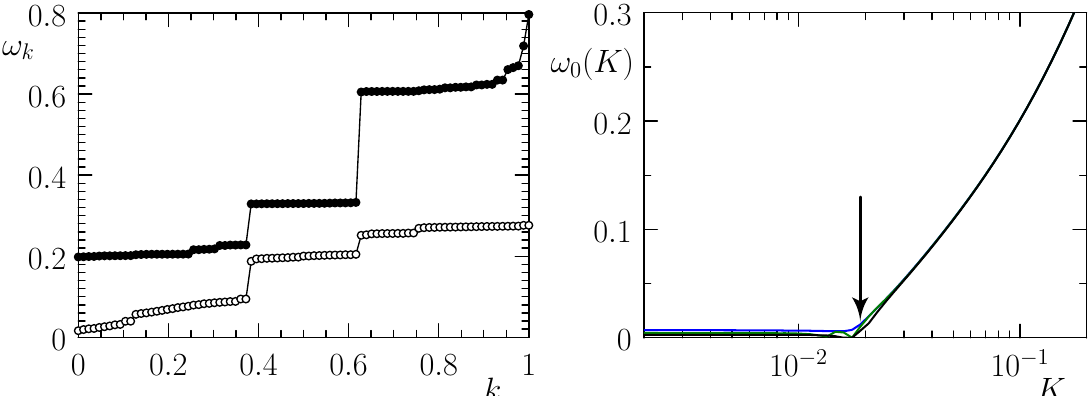
Figure 2. Left panel: phonon spectrum ω ( k ) for K = 0.02 (open circles) and K = 0.1 (full circles) for ν = N / L = 89/55. Right panel: dependence of the lowest phonon frequency ω 0 on K for the lattice ν g = 1.618...: N / L = 55/34 (blue curve), 89/55 with N dipole atoms in L lattice periods at density ν ≈ (green curve), 144/89 (black curve); the arrow marks the point of the Aubry transition at K c = 0.019 defined as it is described in the